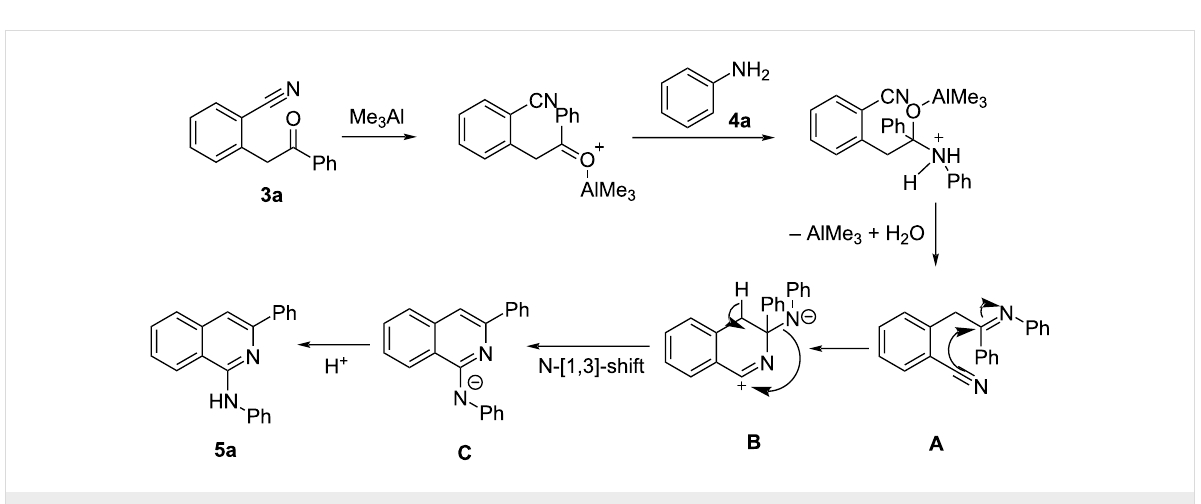
Scheme 5: Proposed mechanism for the synthesis of 1-aminoisoquinoline 5a